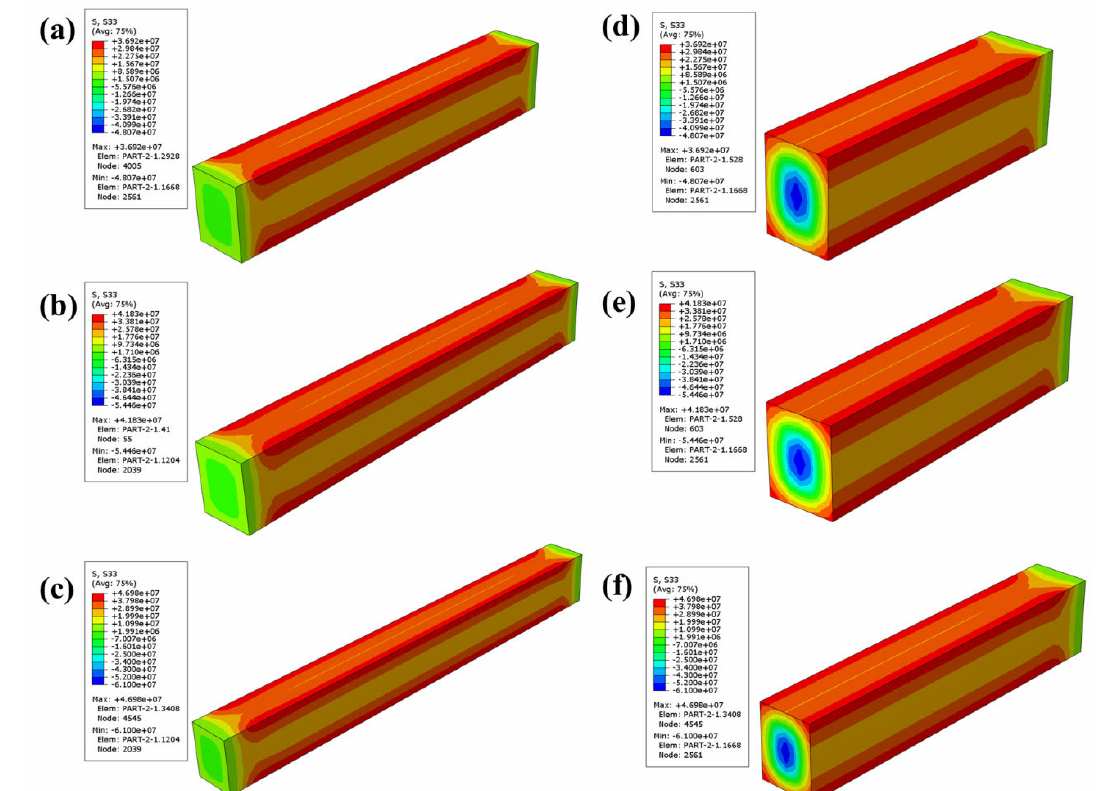
Fig. 4 Thermal stress distribution after rapid cooling thermal shock testing: (a, d) T  = 400 ℃ , (b, e) T  = 600 ℃ , and (c, f) T  = 800 ℃